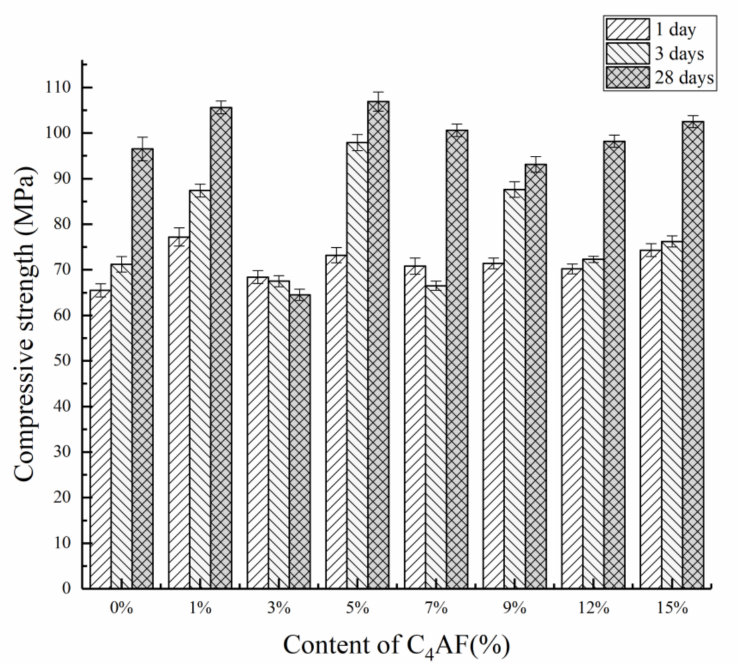
Figure 1. Compressive strength of the different C 4 AF content of the clinker at 1350 ◦ C.